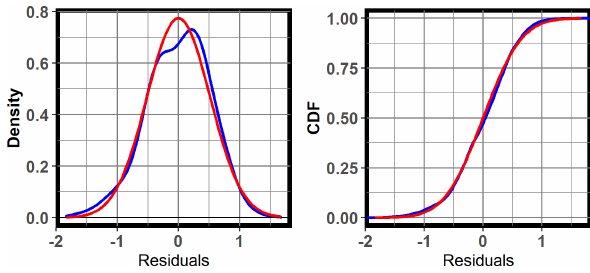
Figure 8: Goodness of fit of the residual distribution of the AR- MAX(2,2) model to normal distribution